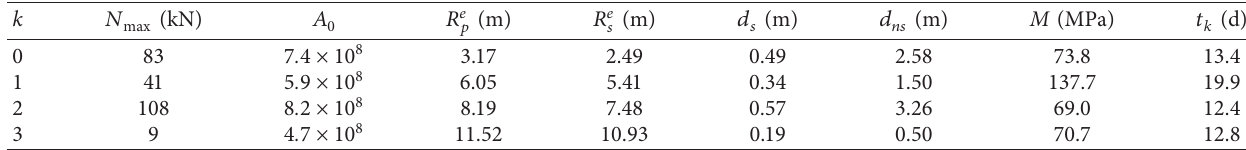
Table 4: Calculation results of creep fracture moment of the Qinling water diversion tunnel.